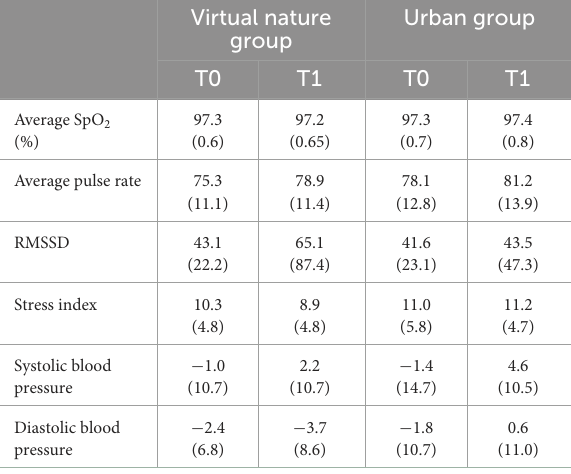
TABLE 2 Mean scores and standard deviations of the physiological stress variables in the virtual nature group and urban group ( N = 28). Virtual nature Urban group